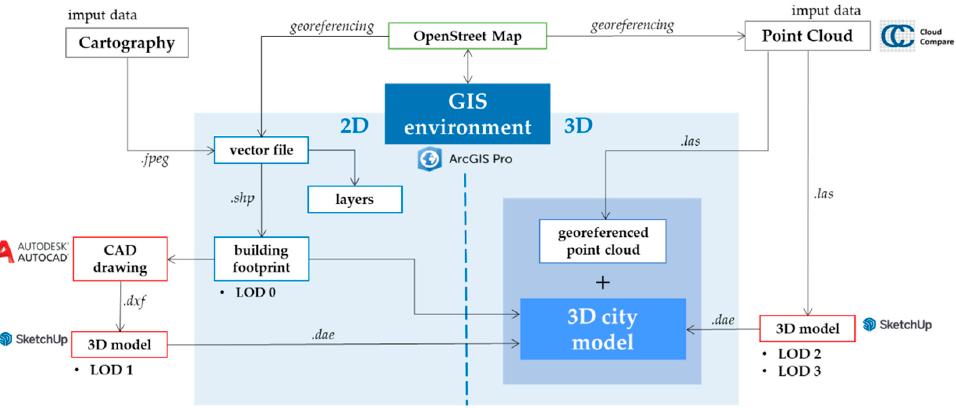
Figure 9. Elaboration scheme of 2D/3D model for GIS.